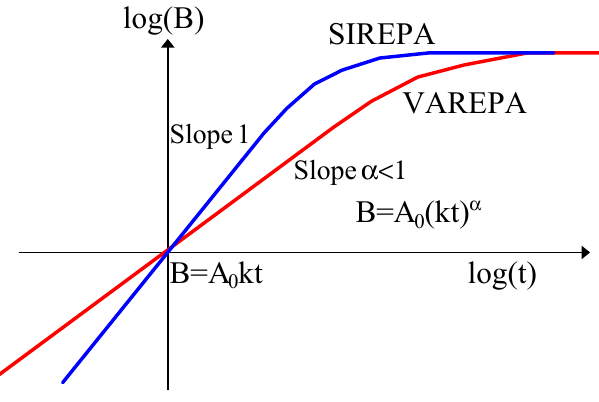
Figure 18. VAREPA kinetics compared SIREPA. log(B) vs.